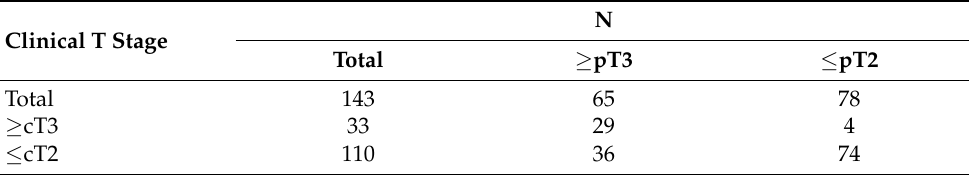
Figure 1. Subgroup analyses of the prognostic effects of ureterorenoscopy on overall survival ( A ) and progression-free survival ( B ). Table 3. Associations of image-based clinical T stage with pathological T stage.